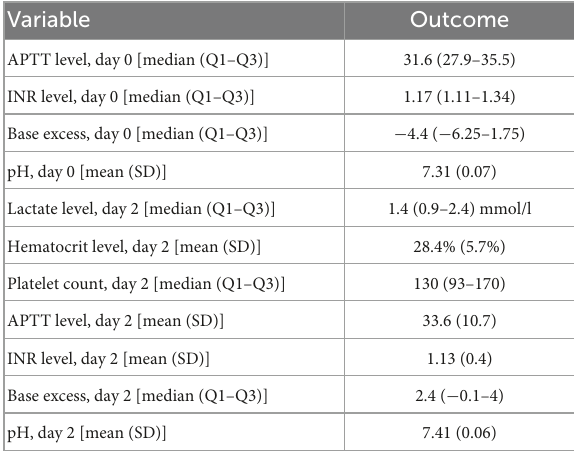
TABLE 1 Summary of clinical data for all patients.